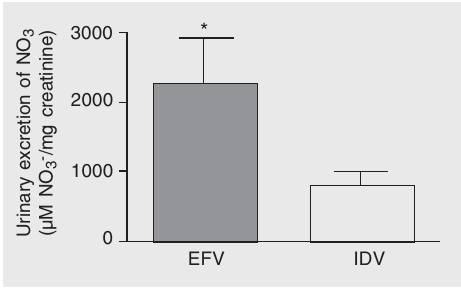
Figure 1. NO 3 excretion by IDV- treated (N = 18) and EFV-treated (N = 8) patients. IDV = indinavir; EFV = efavirenz. *P < 0.05 com- pared to the IDV group (Mann- Whitney